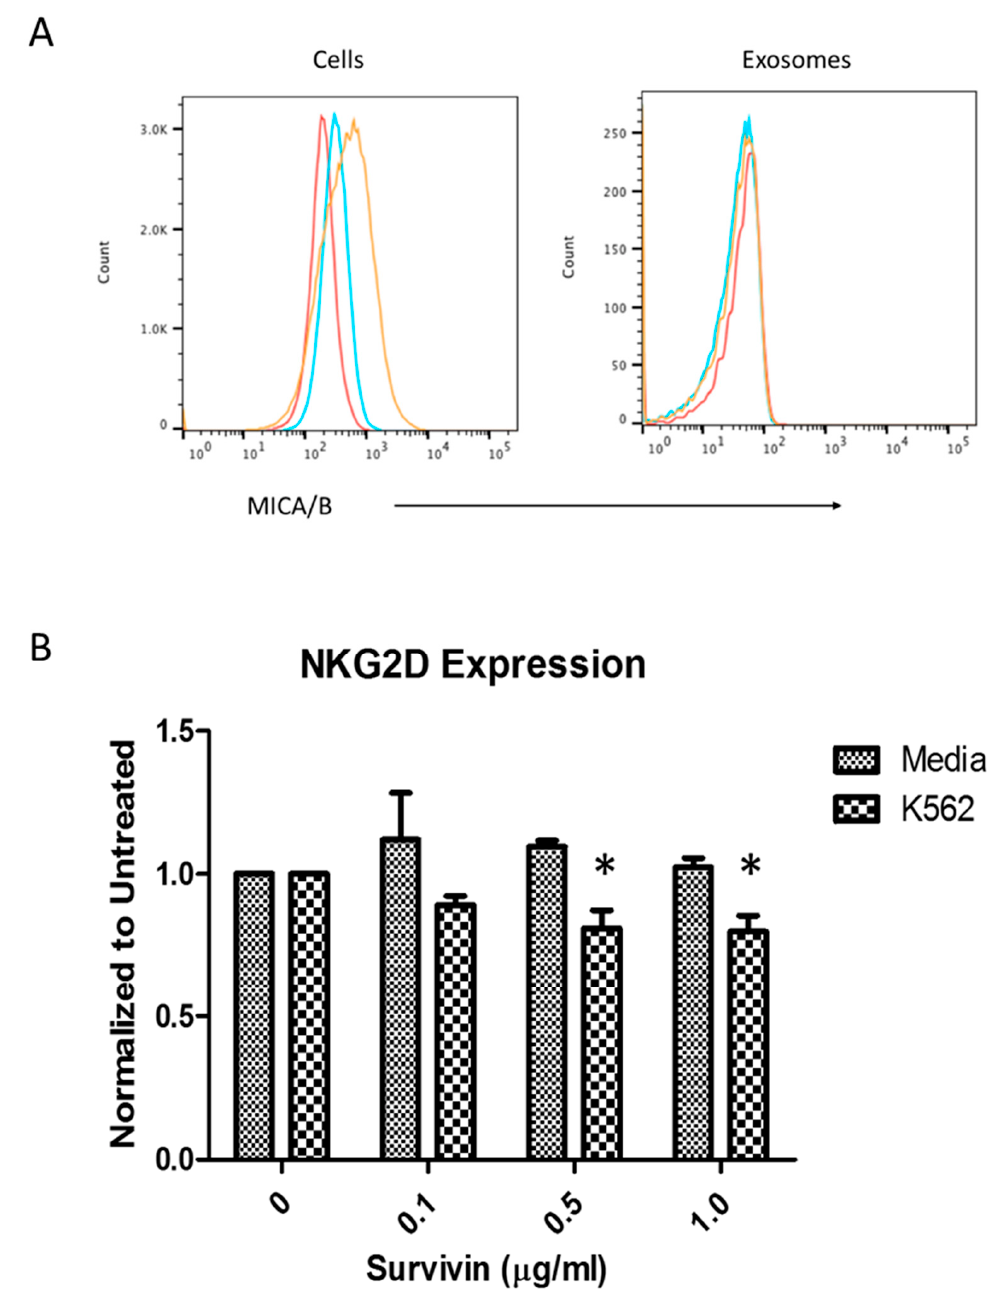
Figure 3. Natural killer group 2D receptor ligands (NKG2DL) were present on lymphoma cells but not exosomes, and treatment with survivin protein decreased natural killer group 2D receptor (NKG2D) expression. ( A ) Flow cytometry indicates that lymphoma cells expressed MHC class I-related chains (MICA)/B (an NKG2DL), but exosomes from these two lymphoma cell lines did not. Red = isotype, blue = DLCL2, orange = FSCCL. ( B ) NKG2D expression on natural killer (NK) cells (CD56+) after treatment with survivin (0–1.0 µ g/mL). NK cells were activated by IL-2 (100 U/mL) and K562 (5 × 10 5 /well) target cells and treated with survivin for 24 h. The receptor expression was assessed by mean fluorescence intensity (MFI) measured by fluorescent staining with NKG2D–APC antibody. MFI was normalized to an untreated group and data are presented as mean ( ± SEM) of three independent experiments (* is p < 0.05), survivin treatment versus untreated control. Data were collected on a Miltenyi MACSQuant Analyzer flow cytometer and analyzed using FlowJo v10.0.8p